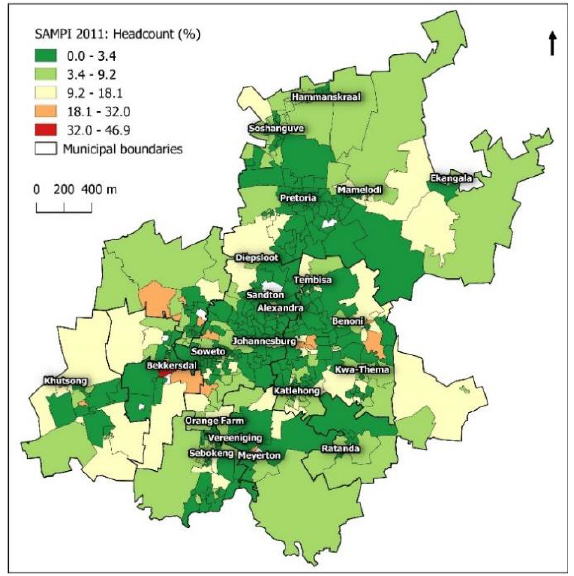
The variables are defined the same as the ones in the global